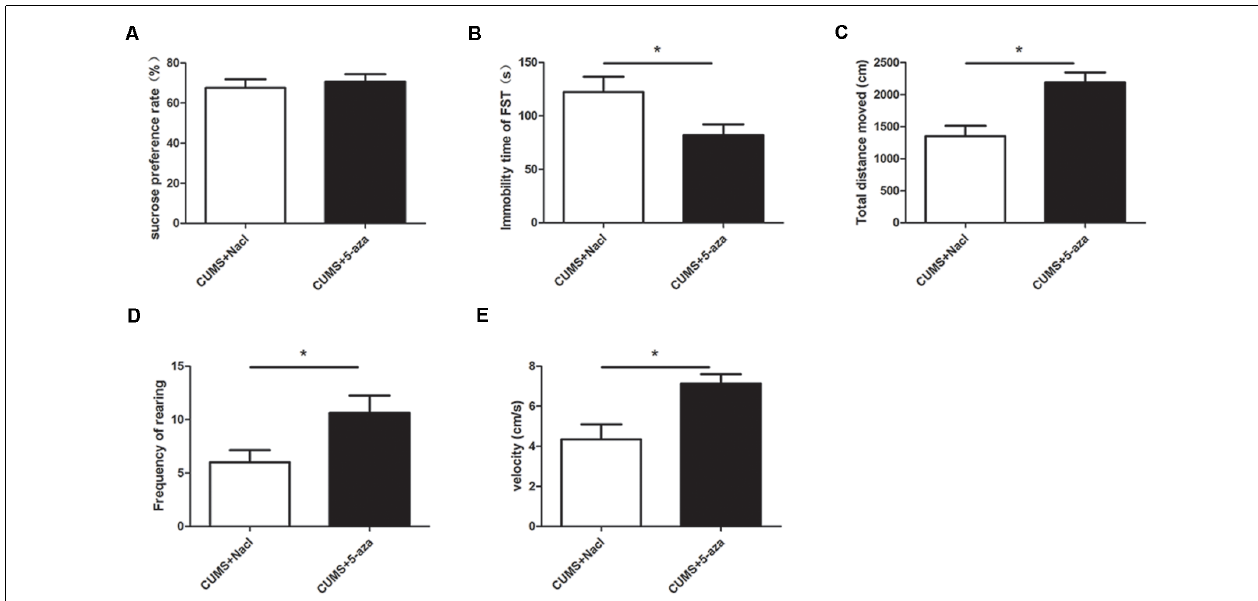
FIGURE 6 | Effect of microinjecting 5-aza into the hippocampal CA1 region on depressive-like behaviors: sucrose preference rate in the SPT (A) , immobility time in the FST (B) , total distance traveled (C) , rearing frequency (D) , and velocity (E) in the OFT. * P < 0.05.